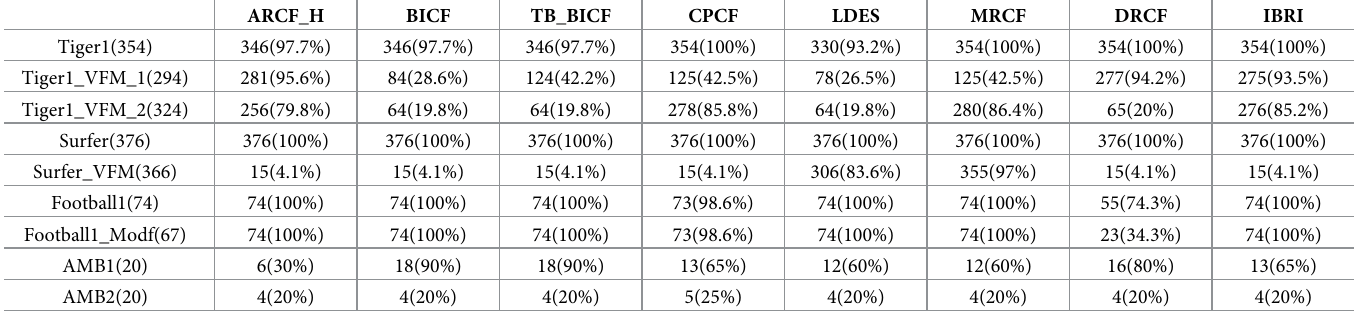
Table 3. The percentage of frames the trackers managed to capture the object from the entire